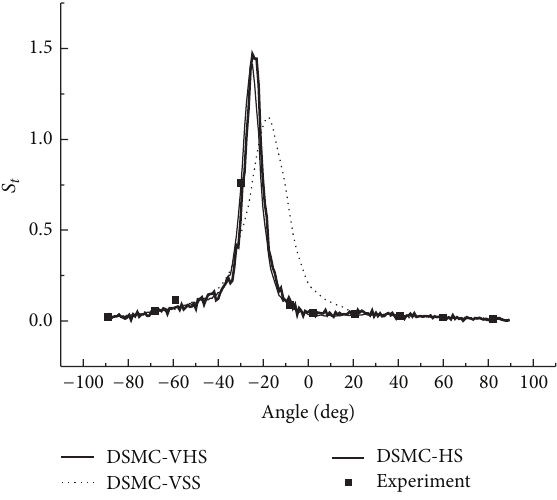
Figure 22: DSMC of type IV shock interaction ( 𝐶 𝑃 ). Figure 23: DSMC of type IV shock interaction ( 𝑆 𝑡